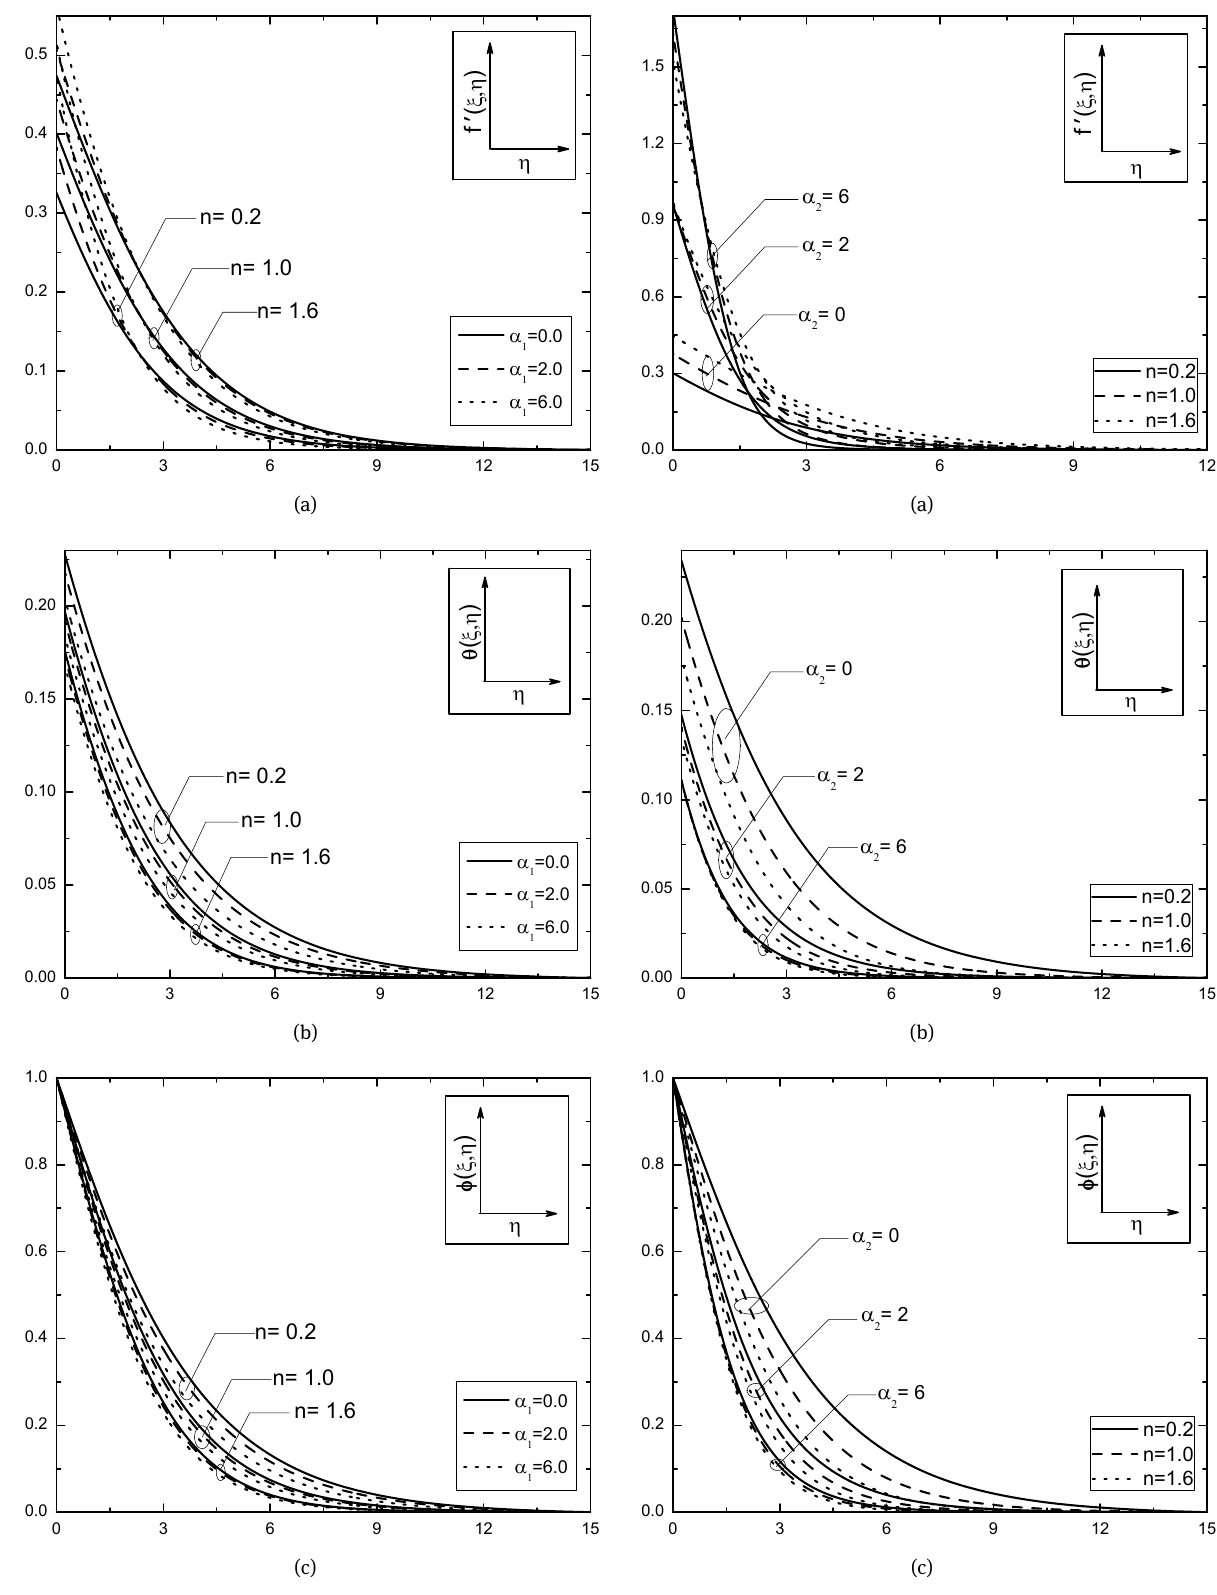
Fig. 3: Effect of α 1 for different of values n on the (a) f ′ ( ξ , η ) , (b) θ ( ξ , η ) , and (c) ϕ ( ξ , η ) with the fixed values of Bi = 0.5 , α 2 = 1 , Ω = 30 0 , ξ = 0.5 .